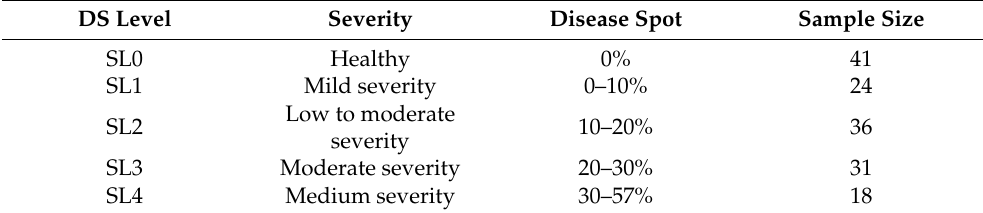
Table 1. Classification of disease severity.